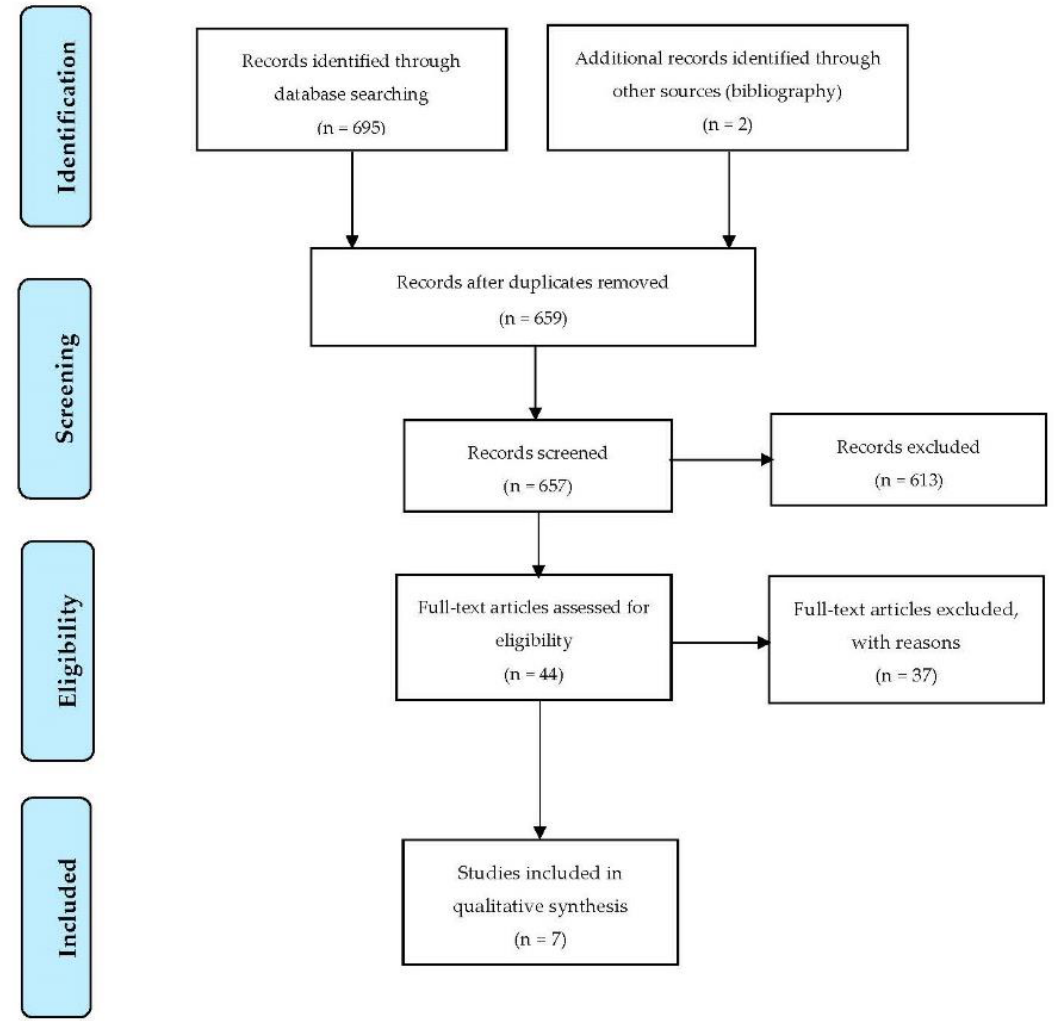
Figure 1. Preferred Reporting Items for Systematic Reviews and Meta-Analyses (PRISMA) flowchart for selection of eligible studies [41].